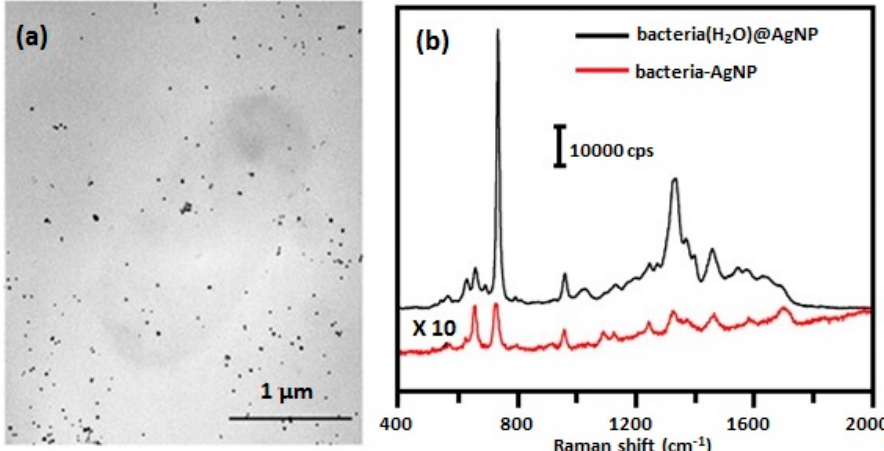
Figure 10. ( a ) TEM image of E. coli 1116 mixed with Ag NPs and 0.01 M NaCl (bacteria-AgNP) [38]. ( b ) SERS spectra obtained for E. coli 1116 obtained by two different methods: external colloid formation, bacteria(H 2 O)@AgNP, and mixing bacteria with Ag colloid, bacteria-AgNP [38]. Spectra were obtained using 633 nm excitation. Each sample was measured three times. Reproduced with permission from the American Chemical Society.